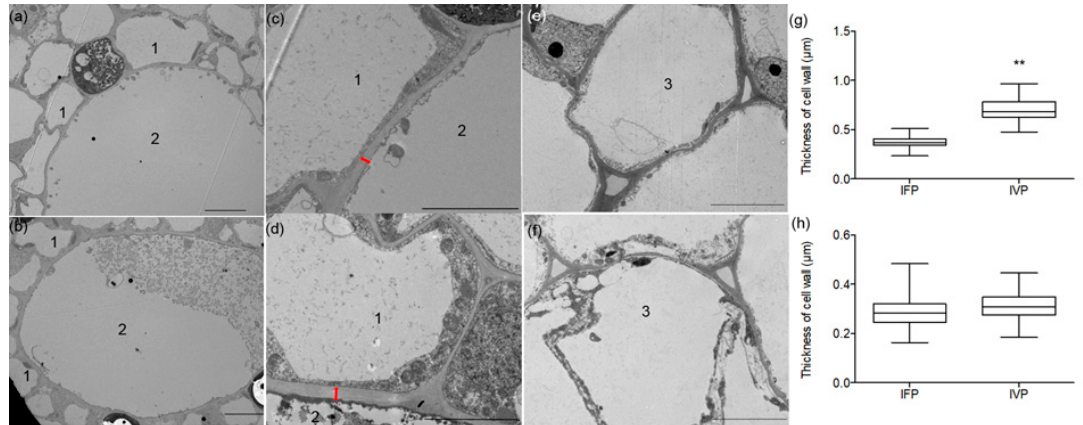
Figure 3. Thickness of cell wall in lotus petioles was observed using a transmission electron microscope. ( a , c ) shows cell wall thickness of xylem vessels in IFP; ( b , d ) shows cell wall thickness of xylem vessels in IVP; ( e , f ) show thickness of parenchymatous cell wall of IFP and IVP, respectively. The Arabic numerals 1 indicates sclerenchyma cell; Arabic numerals 2 indicates xylem cell, The Arabic numerals 3 indicates parenchymatous cell; ( g , h ) statistics of thickness of the cell wall of xylem vessels and parenchymatous cell in IFP and IVP, respectively. Data are means ± SD from 10 independent transverse sections (IFP and IVP). Double asterisks indicate significant changes compared to IFP as assessed according to Student’s t -test (** p < 0.01). Bars in figures indicate 10 μ m.